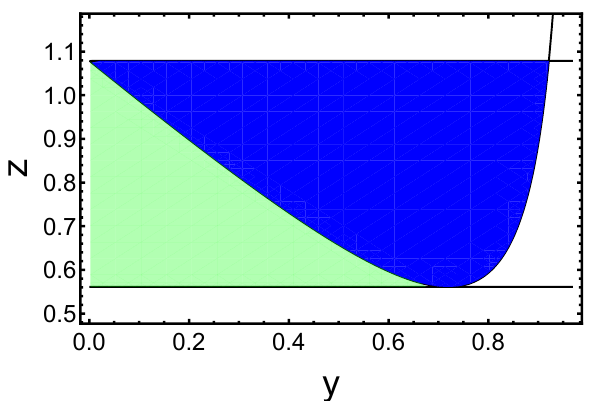
Figure 3 . Illustration of the D 3 region (dark blue) and D 4 − 3 region (light green) in K 0